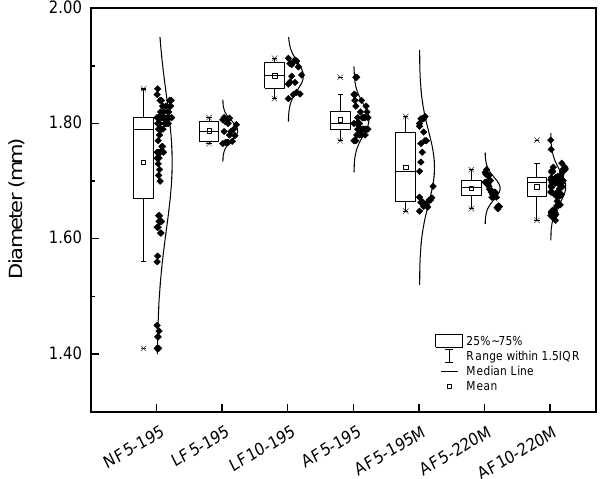
Figure 3. Influence of operational parameters on filament diameter distribution (asterisks represent the outliers, black squares the data and the curved lines the density functions).